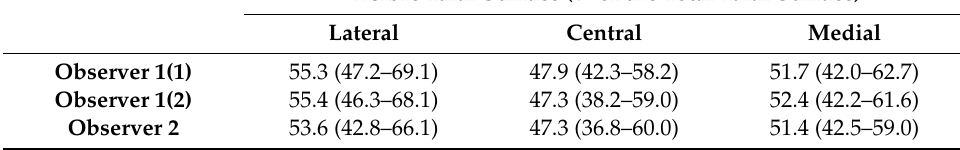
Table 3. The average percentage of the talar surface that could be visualized with US from two observers for the lateral, central and medial part of the talus. Observer 1 served as an internal control by performing the analysis twice: Observer 1(1) and Observer